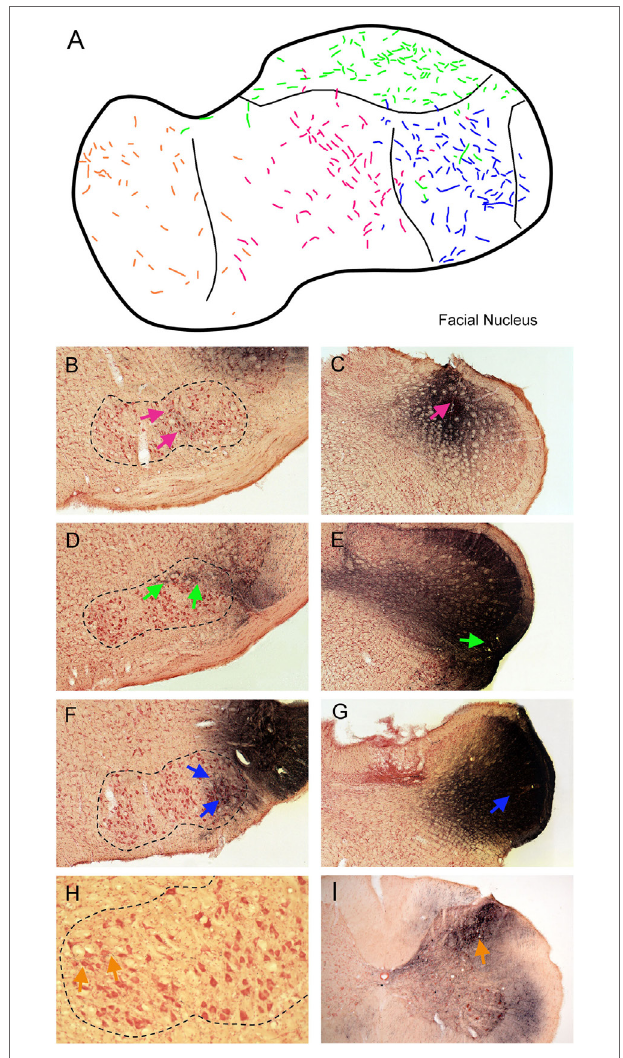
FigUre 4 | Line drawings and photomicrographs illustrating the anterograde transport of biotinylated dextran amine (BDA) into the facial motor nucleus after injections into deep lamina of different rostrocaudal levels of the trigeminocervical complex. Transported label to intermediate parts of the facial nucleus is seen in (B) (red arrows) after an injection centered in laminae III–IV of the rostral medullary dorsal horn (MDH) [ (c) ; red arrow]. Similarly, an injection centered in lamina V of the ventrolateral parts of the rostral MDH [ (e) ; green arrow] resulted in transported label to dorsolateral parts of the FN [ (D) ; green arrows] while an injection more caudally in lamina V [ (g) ; blue arrow] labeled ventrolateral parts of the FN [ (F) ; blue arrows]. We suspect appearance of the large size of these injections is due to robust filling of lamina V neurons with dendrites extending to more superficial laminae. Finally, an injection of BDA into lamina V of the C4 level of the spinal dorsal horn [ (i) ; orange arrow] resulted in label in the medial facial nucleus [ (h) ; orange arrows]. These results are summarized in (a) ; color coding of labeled fibers match those imposed on the different injections at different rostrocaudal levels of the trigeminocervical complex seen in (B–i) . When these data are combined with the somatotopy of primary afferent fibers ( Figure 1 ) and retrograde labeling after injections of the FN ( Figure 3 ), a pattern is seen such that homologous body parts represented by sensory systems and motor neurons are tightly coordinated. This synchrony promotes the notion of appropriate simple reflex circuits existing between the somatosensory system and striated motor